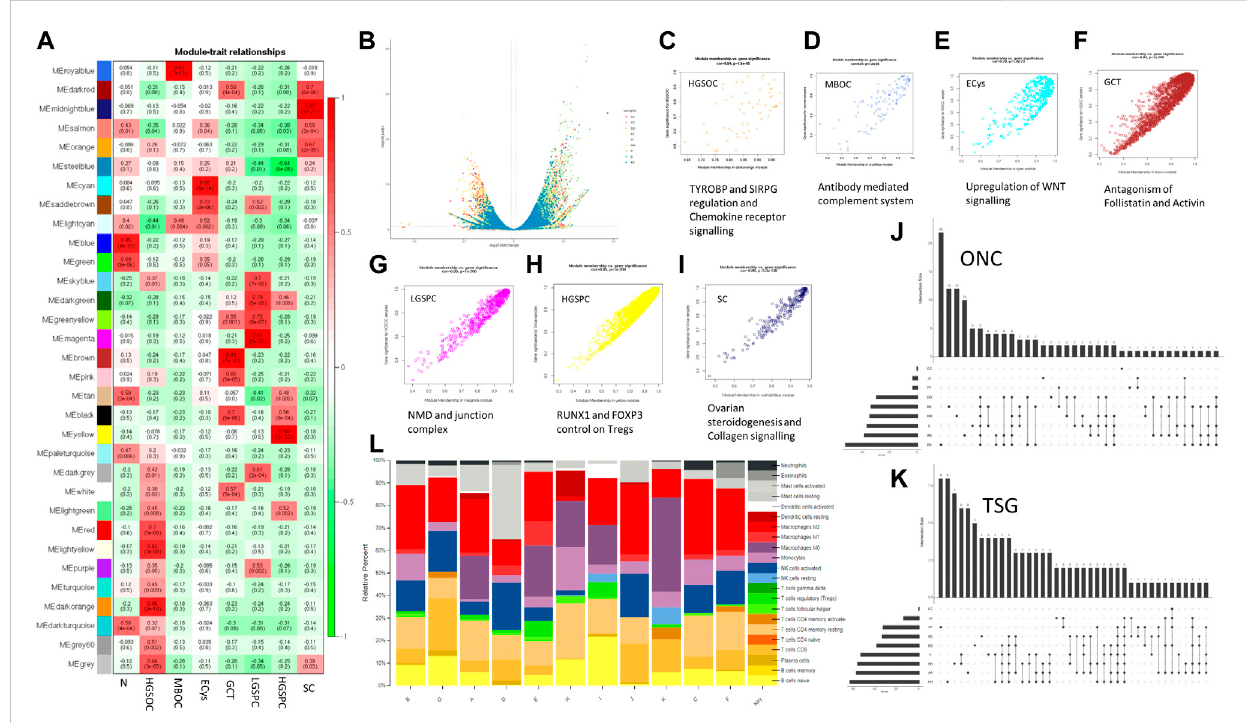
FIGURE 3 Transcriptome analysis of ovarian cancer histotypes. (A) . WGCNA module trait relationship between modules and subtypes (red showing positive correlation with the trait, i.e., the subtype and green showing negative correlation for the same) (B) . Volcano plot showing expression distribution along with signi fi cance for the samples. (C – I) Scatter plot of module trait relationship corelation and its affected pathways for HGSOC, MBOC, ECys, GCT, LGPSC, HGPSC, andSC, respectively. (J) . Upregulated oncogenes(ONC) acrosssubtype samples. (Eachdot indicatestheintersectingsetand y -axis barindicating intersectionsize) (K) .Downregulatedtumoursuppressors(TSG)acrosssubtype samples. (Eachdotindicatestheintersectingsetand y -axis bar indicating intersection size) (L) . CIBERSORTx immune pro fi le of OVCa samples across 22 immune cell subtypes.